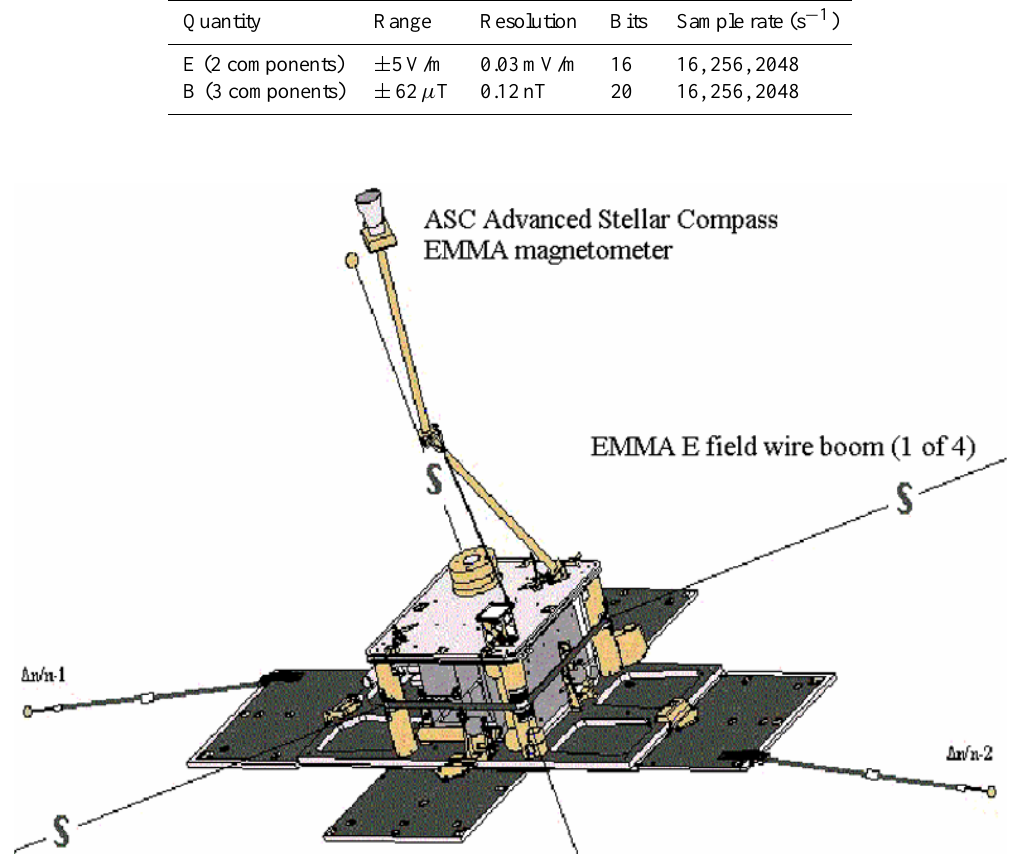
Fig. 1. EMMA sensor